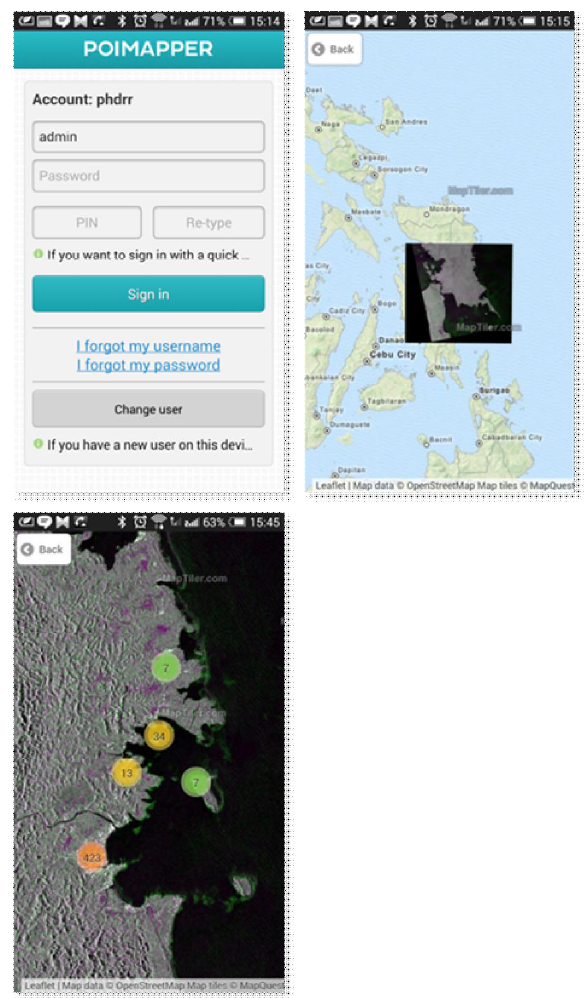
products.Figure 2: Poimapper application used in the emergency pilot for collecting observations by emergency workers and